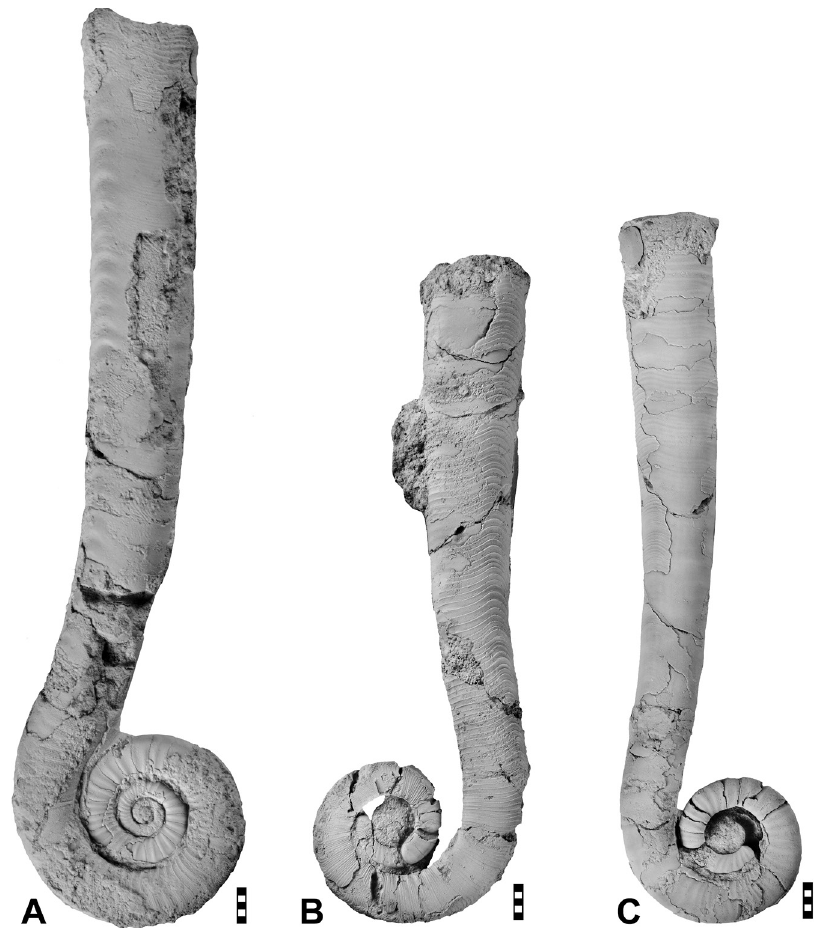
Fig. 58. Species of Lituites from glacial erratics. A . Lituites clavis sp. nov., holotype MB.C.30537 (Neben Coll.) from the Upper Grey Orthoceratite Limestone of Niederfinow (Brandenburg, Germany); previously figured by Neben & Krueger (1971: pl. 31 fig. 3). B . Lituites dewitzi sp. nov., holotype MB.C.30538 (Neben Coll.) from the Schroeteri Limestone of Boltenhagen near Gross Klütz Höved (Mecklenburg-Vorpommern, Germany). C . Lituites nebeni sp. nov., holotype MB.C.30541 (Neben Coll.) from Upper Grey Orthoceratite Limestone of Niederfinow (Brandenburg, Germany); previously figured by Neben & Krueger (1971: pl. 31 fig. 2). Scale bar units = 1